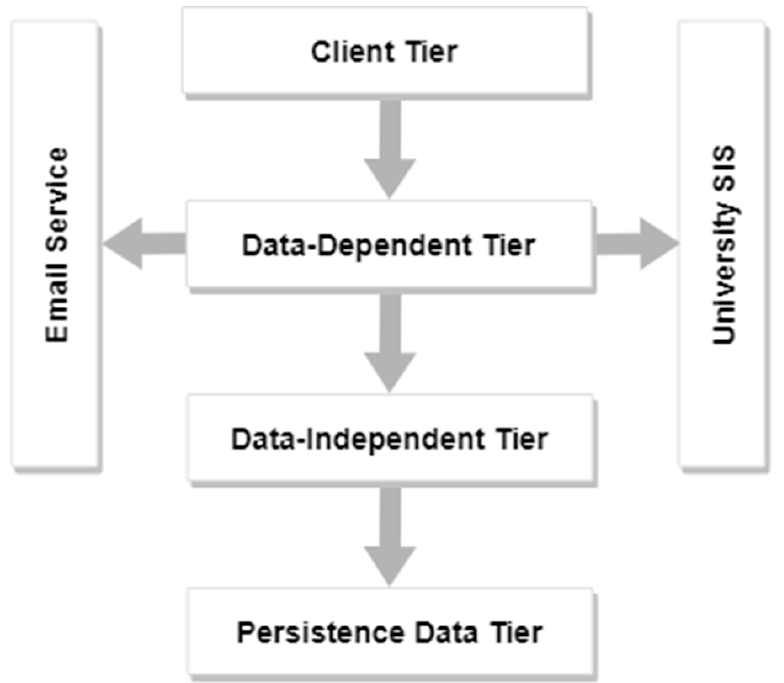
Figure 1. Four-tier